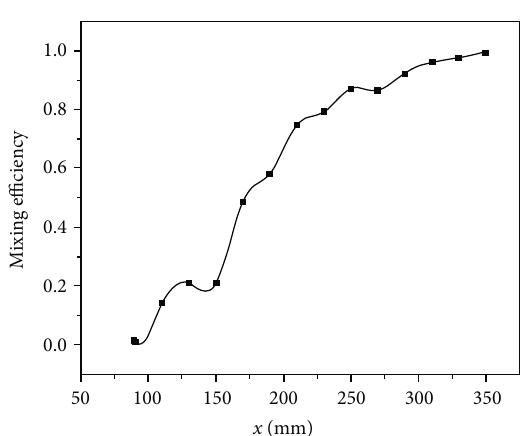
Figure 18: The mixing e ffi ciency at the axis of y = 0mm and z = 50mm plane.